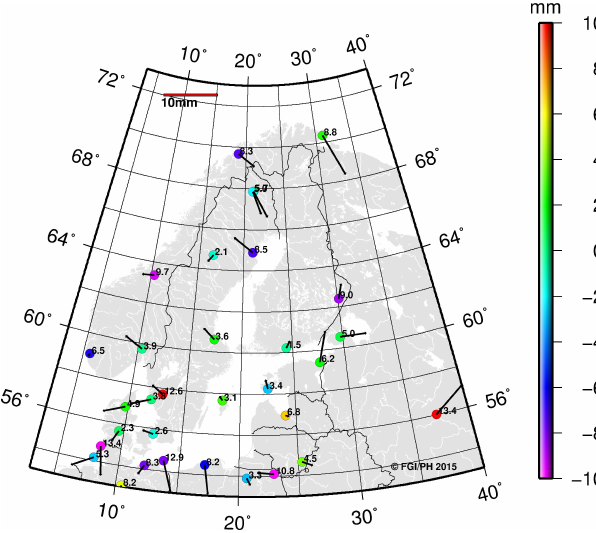
Figure 5: Coordinate differences NKG ETRF 00 minus EPNC1785 (expressed in ETRF2000 at the epoch 2000.0). Vectors show hor- izontal, coloured circles vertical and values next to the station 3D differences in mm. Most of the largest differences can be found out- side the land uplift area ( i.e. subsidence area) or close to it where the NKG RF 03 vel model has its weakest points.